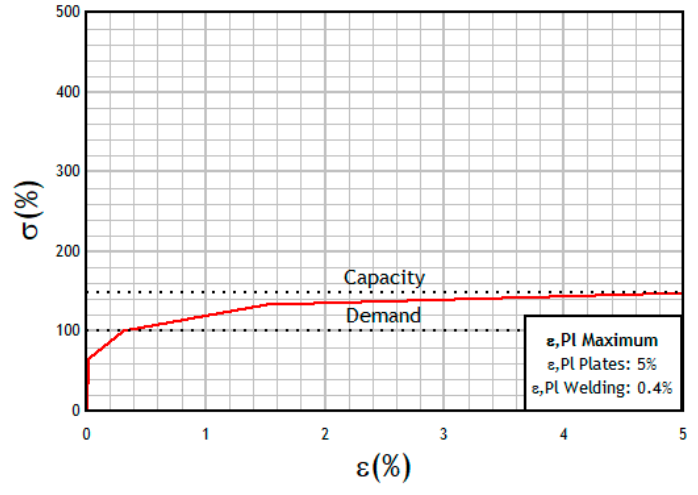
Figure 10. Percentage of strength vs. percentage of strain 8ES EPC NP.